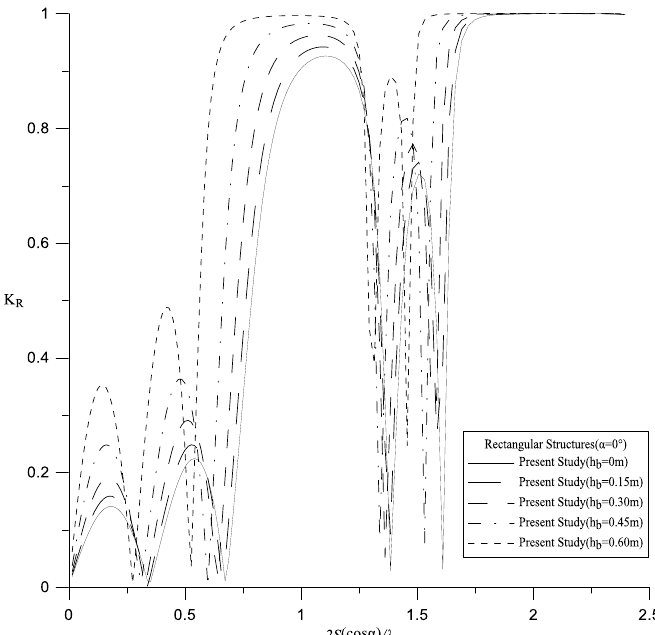
Figure 13. The reflection coefficients for Bragg reflections by periodic rectangular surface-piercing structures over periodic parabolic breakwaters of different heights.